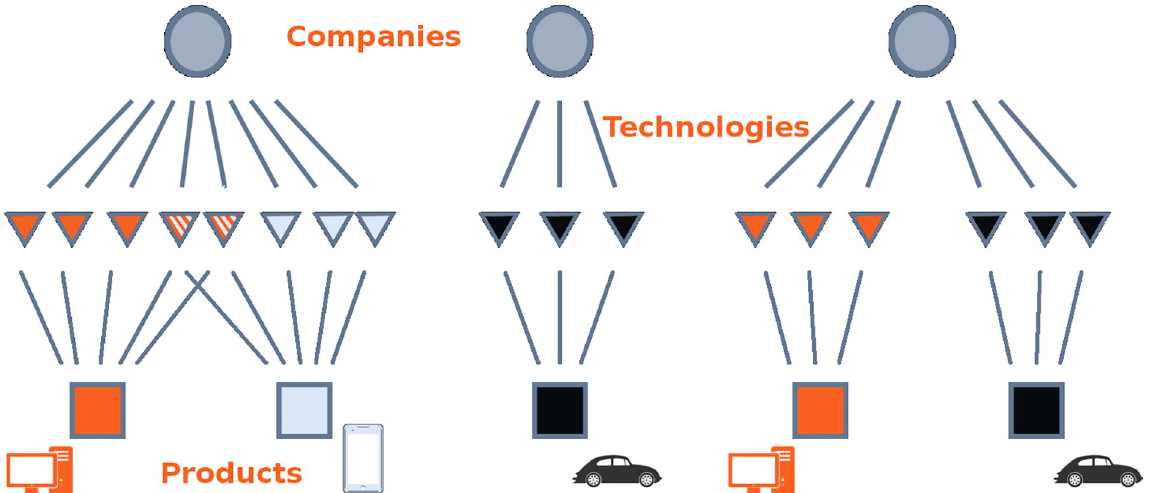
Fig 2. Corporate technological portfolios conceal information about feasible output baskets. Technological portfolios can be used to infer the coherence of companies’ production lines. With respect to Fig 1, where capabilities are the actual, but hidden mediators between economic agents and their output, here the (known) technologies can be seen as enablers for more efficient (but hidden) products.